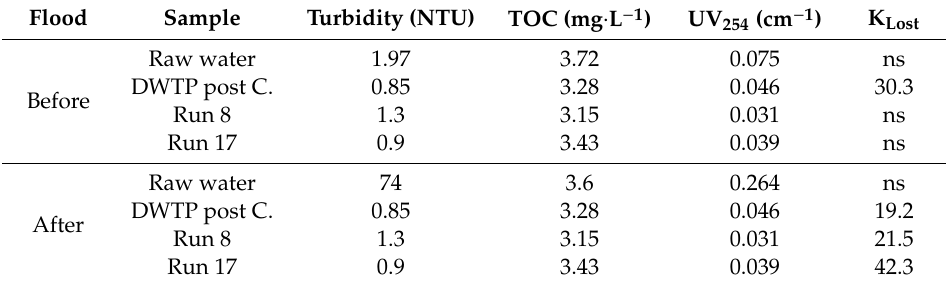
Table 5. Chemical analyzed parameters for each UF experiment.